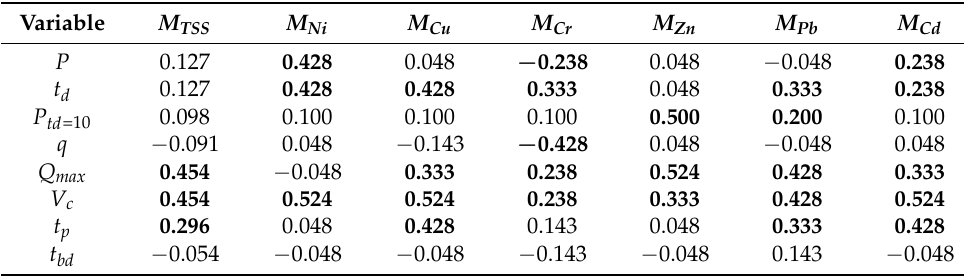
Table 3. The matrix of correlation between the analyzed parameters.